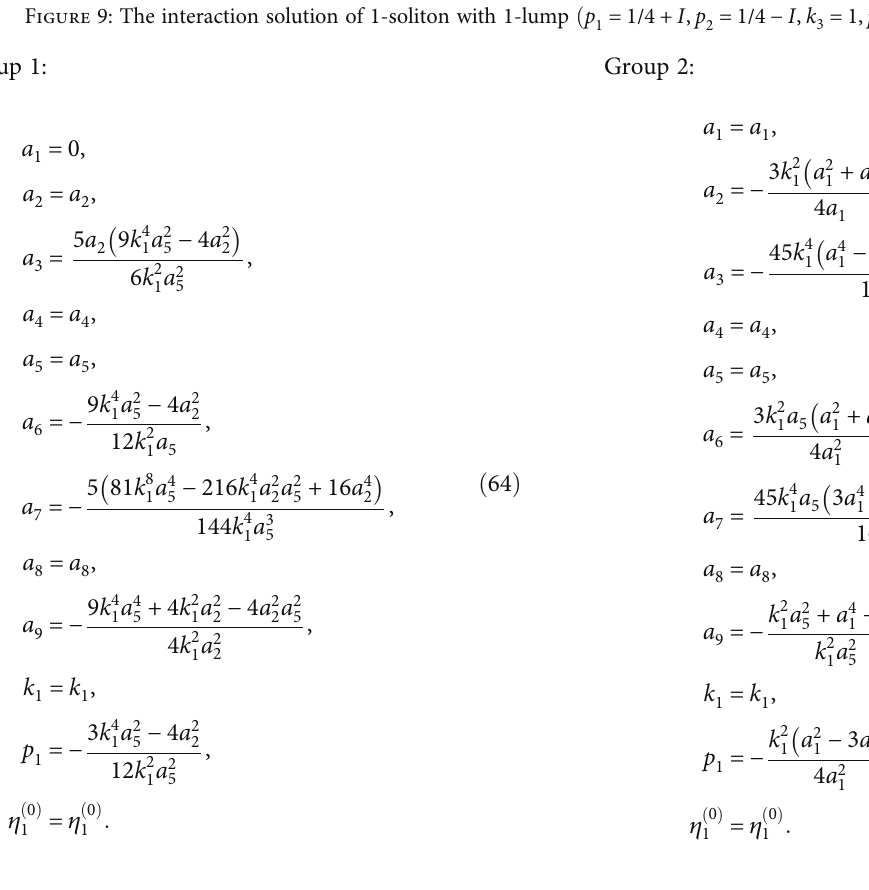
Figure 9: The interaction solution of 1-soliton with 1-lump ð p